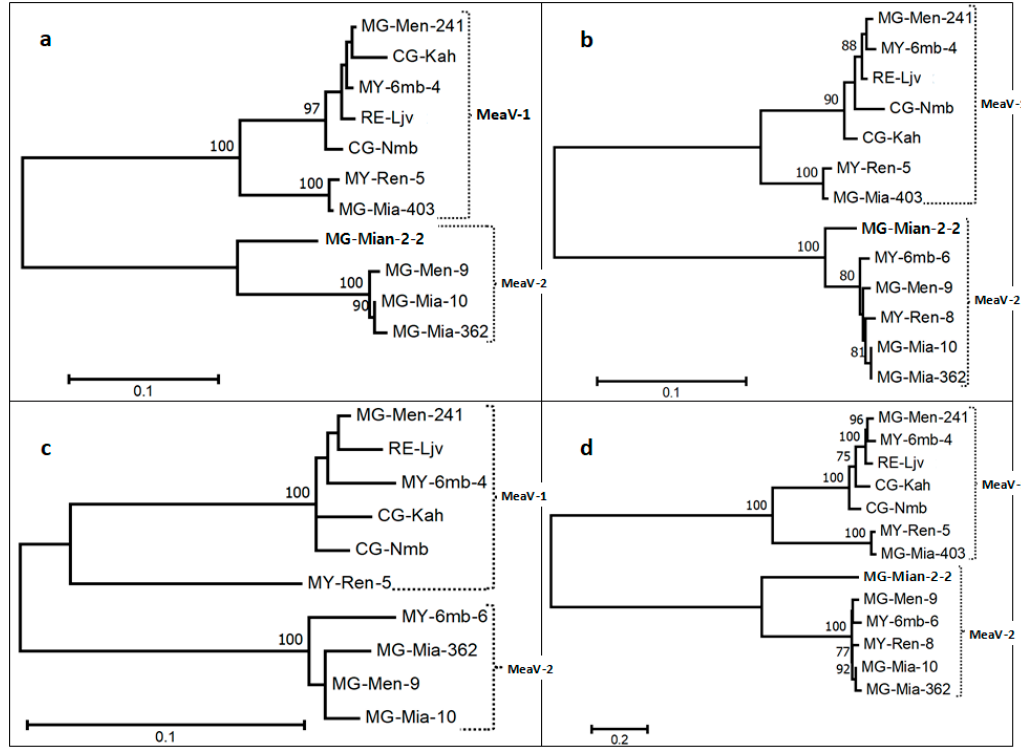
Figure 3. Phylogenetic trees reconstructed using the amino acid sequences of the following three taxonomically relevant proteins for the family Closteroviridae : ( a ) RdRp ; ( b ) HSP70h; ( c ) CP ; and ( d ) the whole genome nucleotide sequences. Maximum likelihood phylogenetic trees were reconstructed in Mega X using the GTR+GI model for nucleotide sequences alignments and a Poisson model with uniform distribution for amino acid sequence alignments. Only bootstrap values of more than 70% are mentioned on nodes. The scales provide branch distance for the given number of substitutions per site. Table 7. Intergroup and intragroup average pairwise divergence and standard deviation calculated for the three taxonom- ically relevant proteins ( RdRP, HSP70h and CP ) and for the nearly complete genomes.